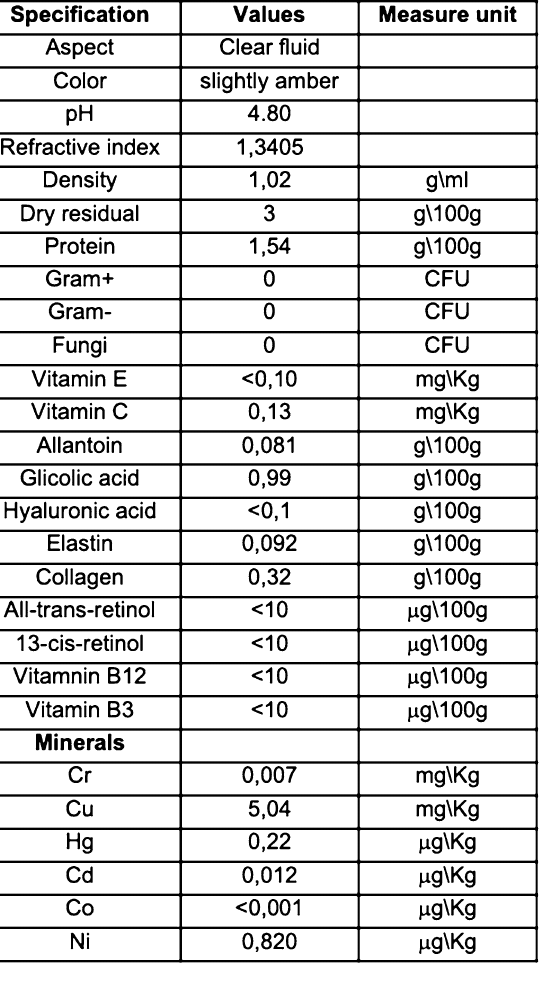
Figure 1. Qualitative and quantitative analysis of crude SSF. Full chemical characterization are shown in supplementary figure